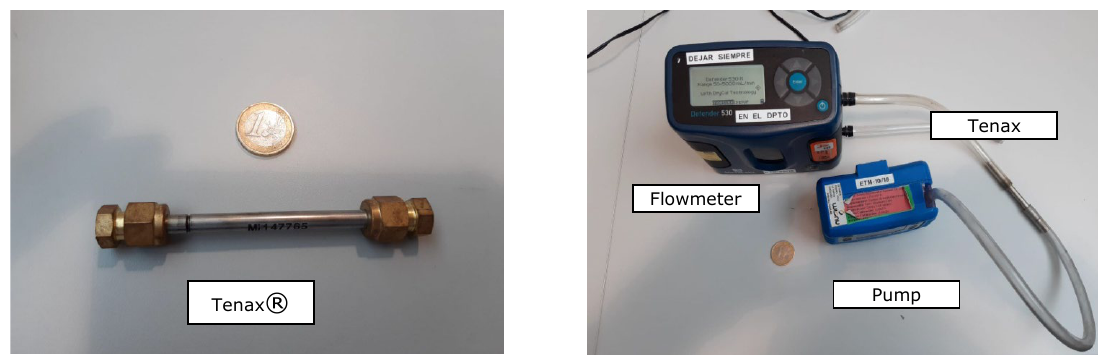
Figure 2 . Tenax® TA sorbent tube (left) and pump calibration (right)